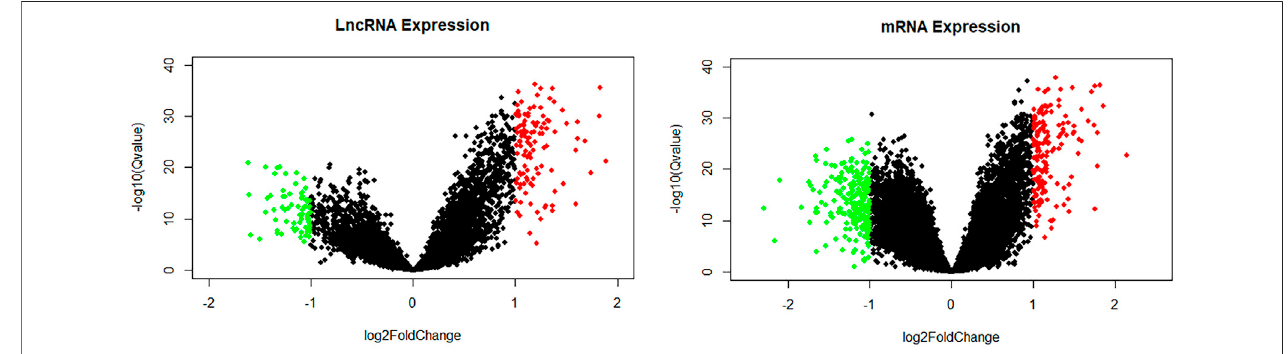
FIGURE3| VolcanomapoflncRNAsandmRNAs.GreenspotsrepresentdownregulatedDElncRNAsorDEmRNAs;redspotsrepresentupregulatedDElncRNAs or